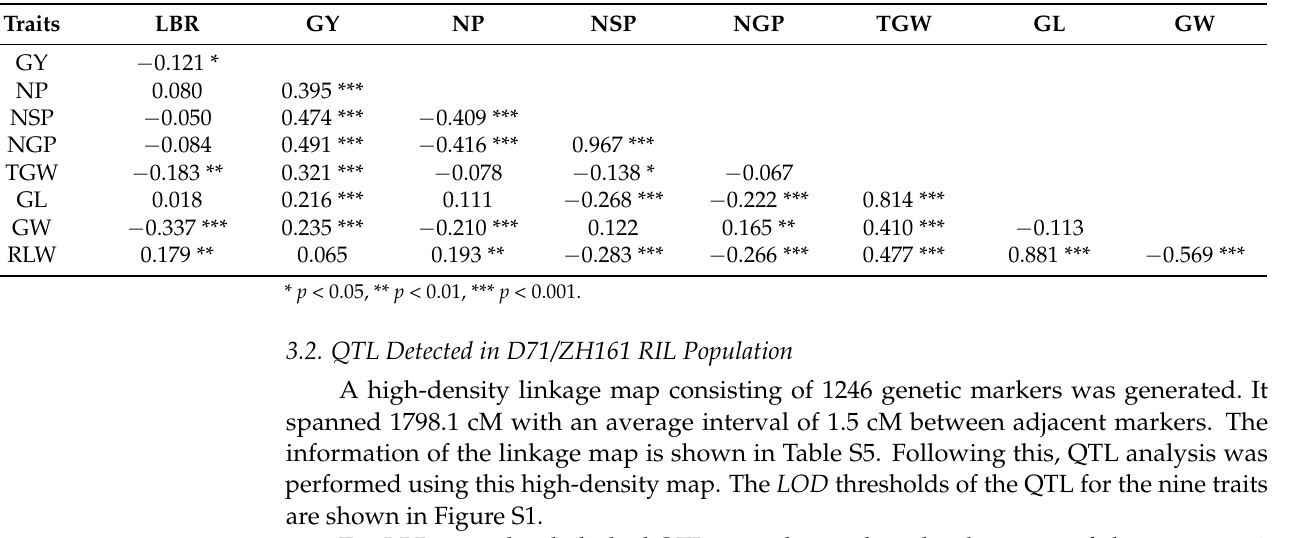
Table 3. Pearson correlation coefficients between the nine traits tested in the D71/ZH161 RIL population.